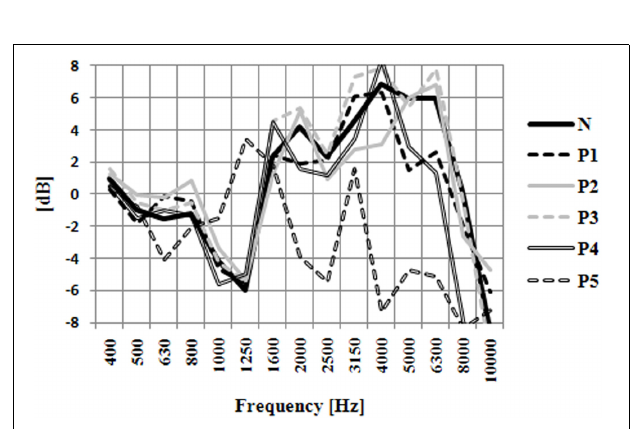
FIGURE 6 | The Interaural Spectral Difference (ISD) for head orientations of 45 (black, dashed line) and 135 ◦ (gray, solid line). The different panels correspond to different HPDs, or to the no-HPD condition (upper-left panel).